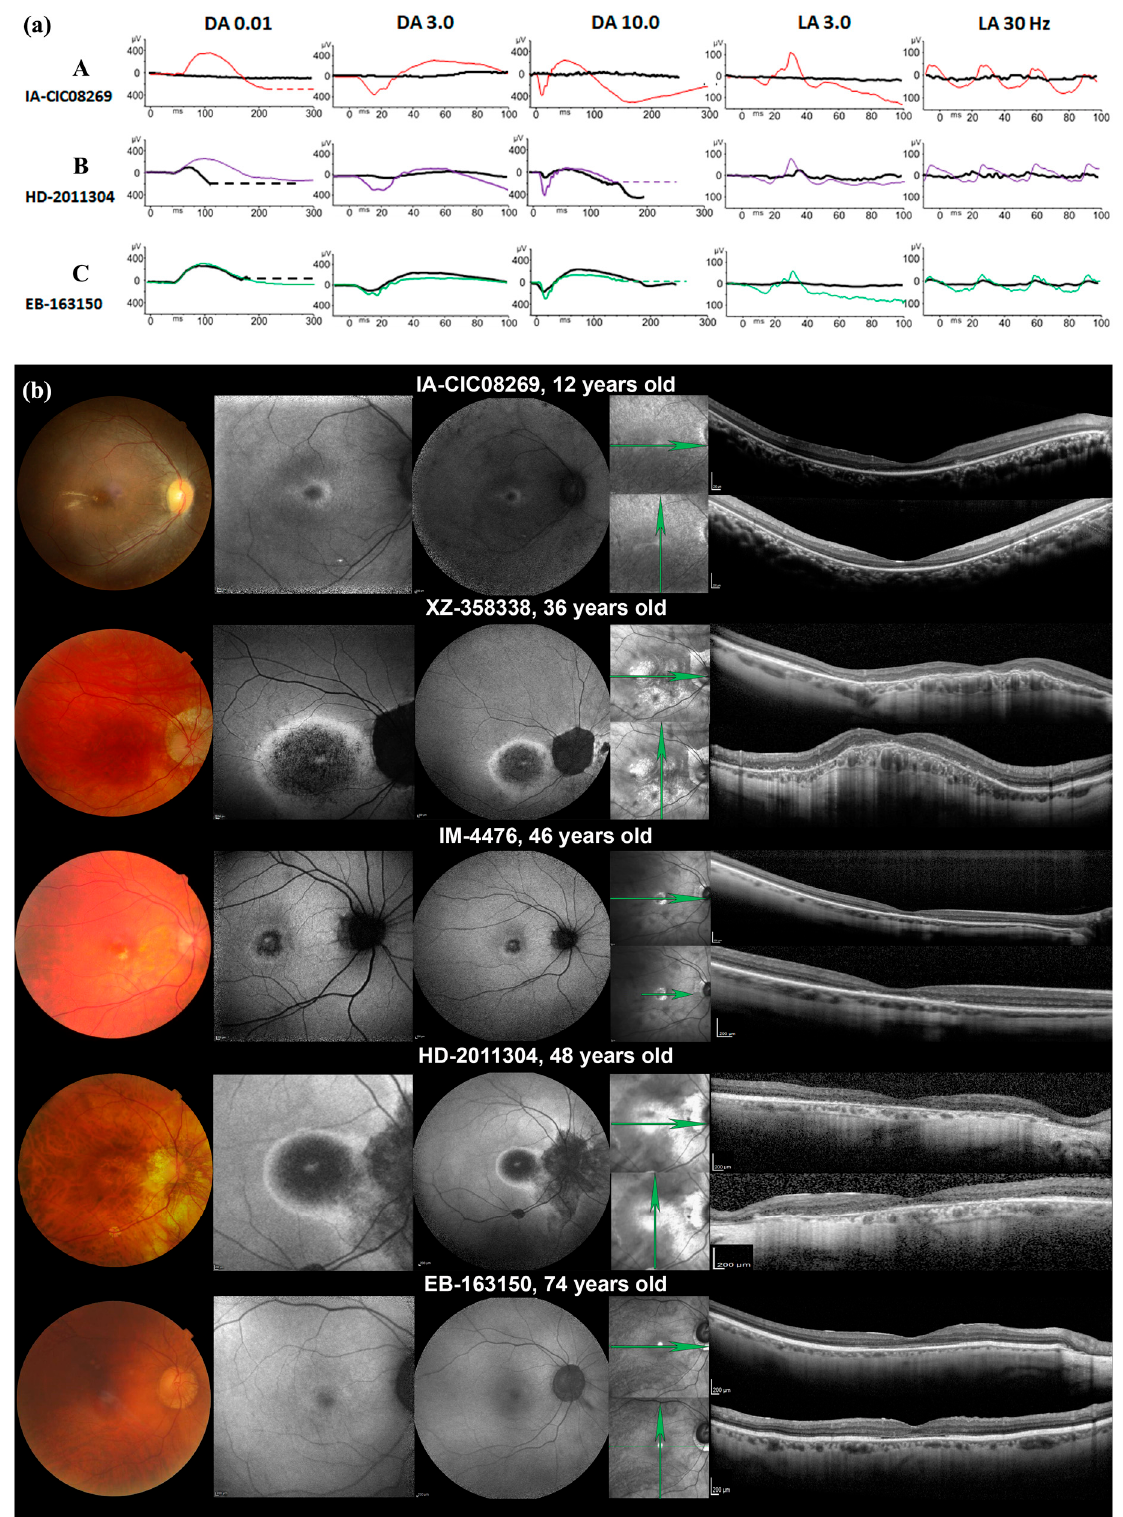
Figure 1. Full-field ISCEV-standard ERGs and Retinal imaging data. ( a ) In bold black, patients’ ffERGs. In thin colour, age- and sex-matched controls. A. Early-onset severe retinal dystrophy. subject IA-CIC08269, 7 y.o. Undetectable dark- and light-adapted responses. B. Cone-rod dystrophy. subject HD-2011304, 48 y.o., mild reduction of dark-adapted responses (DA 0.01, DA 3.0), more pronounced at higher intensity flash (DA 10.0). Severe reduction of light-adapted responses and marked implicit time delay. C. Cone dystrophy. Subject EB-163150, 72 y.o. Normal dark-adapted responses to dim (DA 0.01) and standard (DA 3.0) flash, small a-wave reduction to bright flash (DA 10.0). Residual light-adapted responses; ( b )